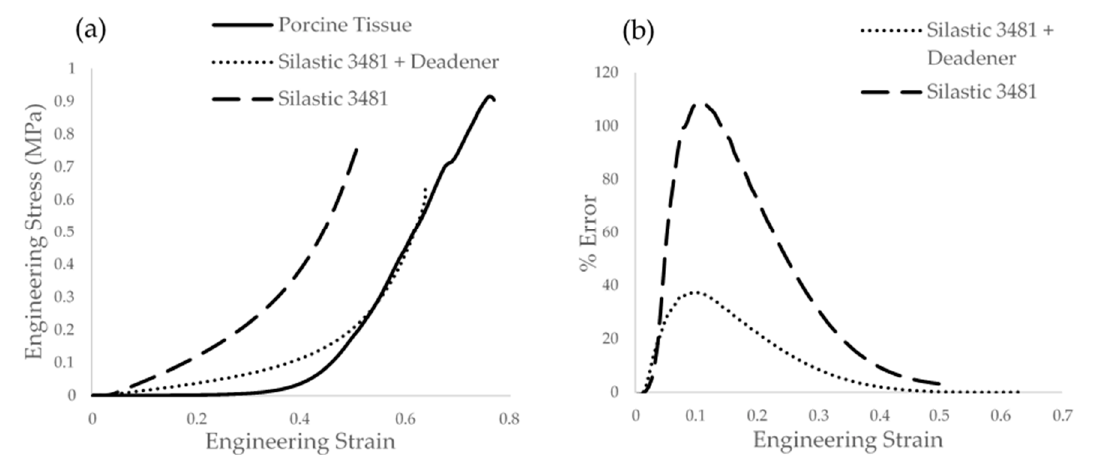
Figure 2. ( a ) Compressive stress-strain plot comparing porcine muscle, Silastic 3481 and Silastic 3481 plus Deadener; ( b ) Percentage difference of Silastic 3481 and Silastic 3481 plus Deadener compared to porcine muscle.